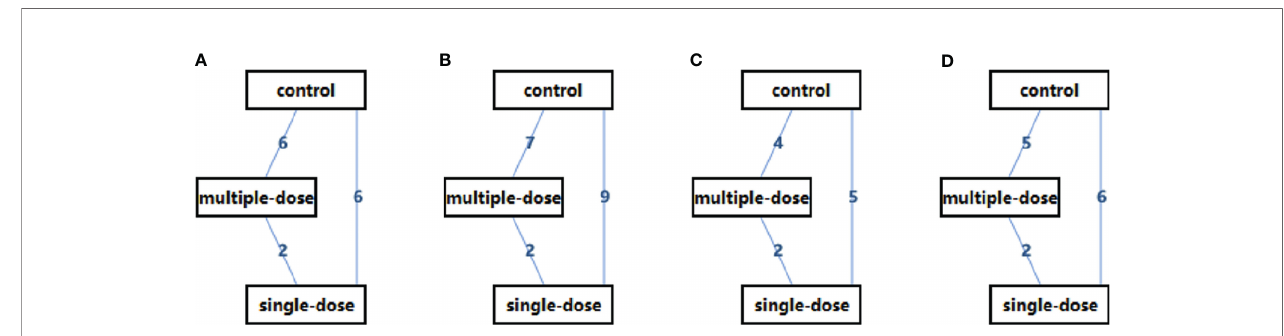
FIGURE 2 | Evidence Network of the eligible studies. (A) live birth rate, (B) clinical pregnancy rate, (C) multiple pregnancy rate, and (D) clinical abortion rate. D, single-dose; MD,